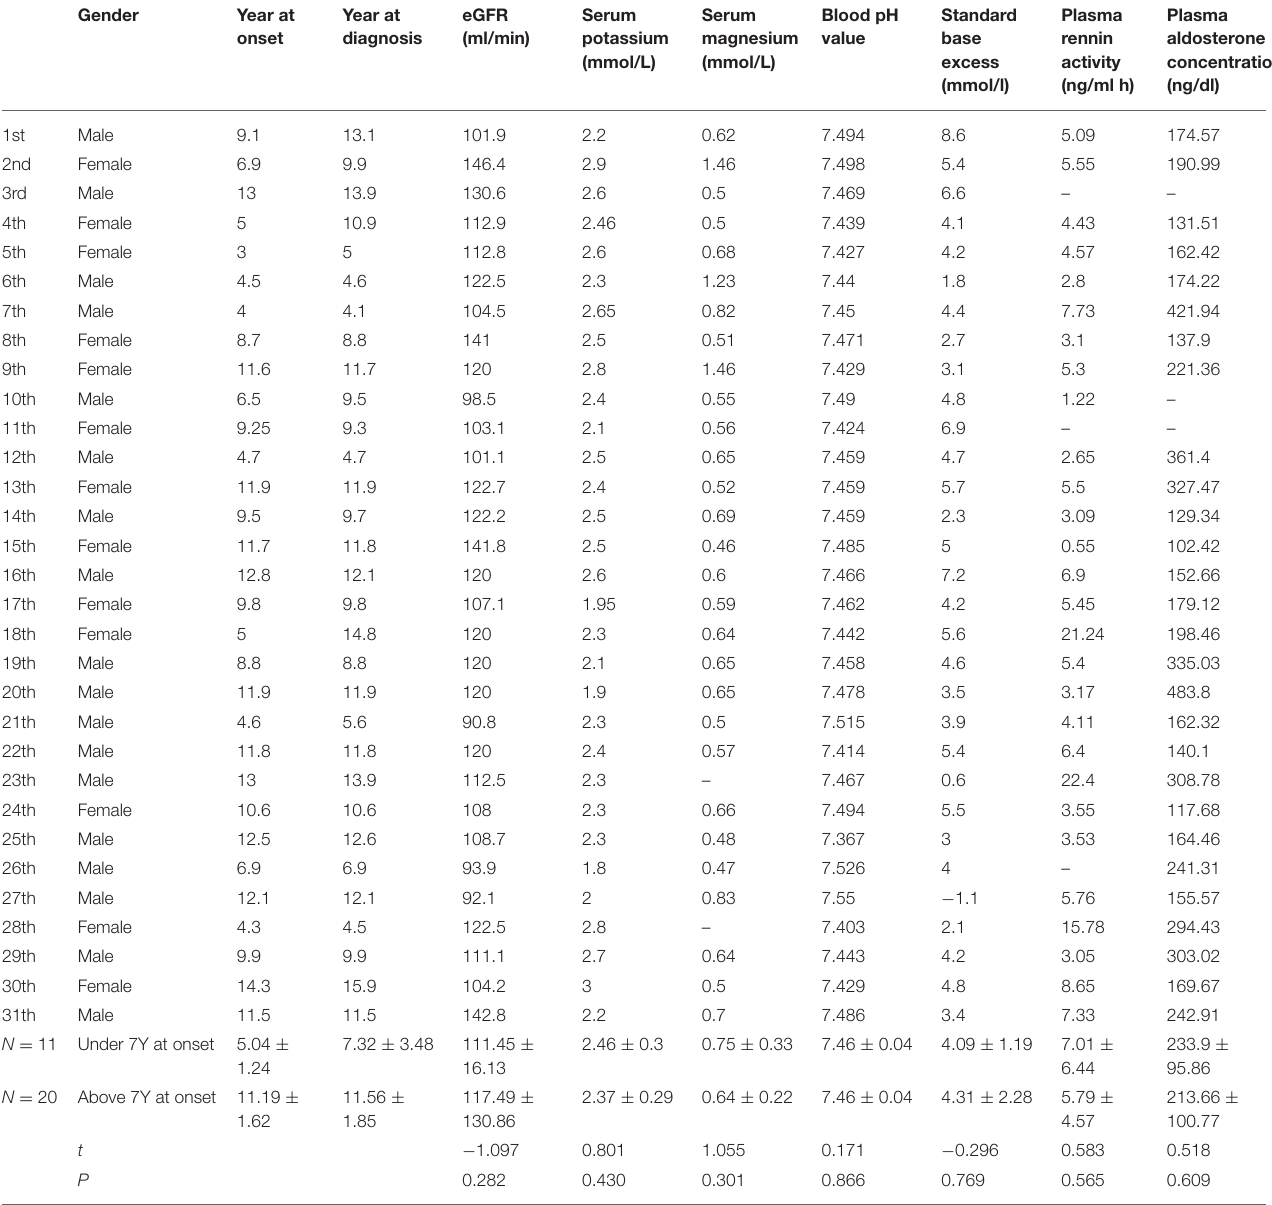
TABLE 1 | Fundamental data and laboratory findings in 31 consecutive children with Gitelman syndrome.